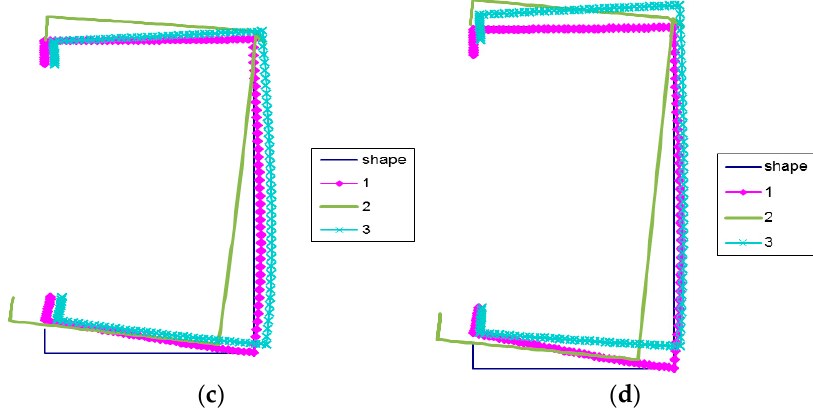
Figure 12. ( a ) Buckling modes for LC-3 beam lengths L = 300 mm, ( b ). Buckling modes for LC-3 beam lengths L = 800 mm, ( c ) Buckling modes for LC-3 beam lengths L = 2500 mm, ( d ) Buckling modes for LC-3 beam lengths L = 4500 mm.